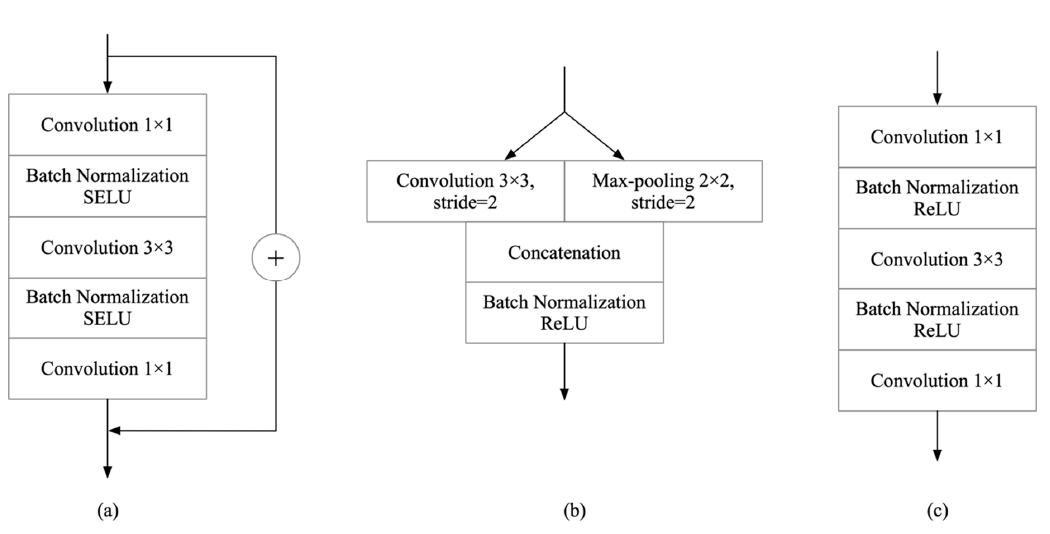
Figure 4. Modules of DE-Net. ( a ) Linear residual block activated by SELU, basic blocks of the encoding module. ( b ) Downsampling module. ( c ) Compressing module.